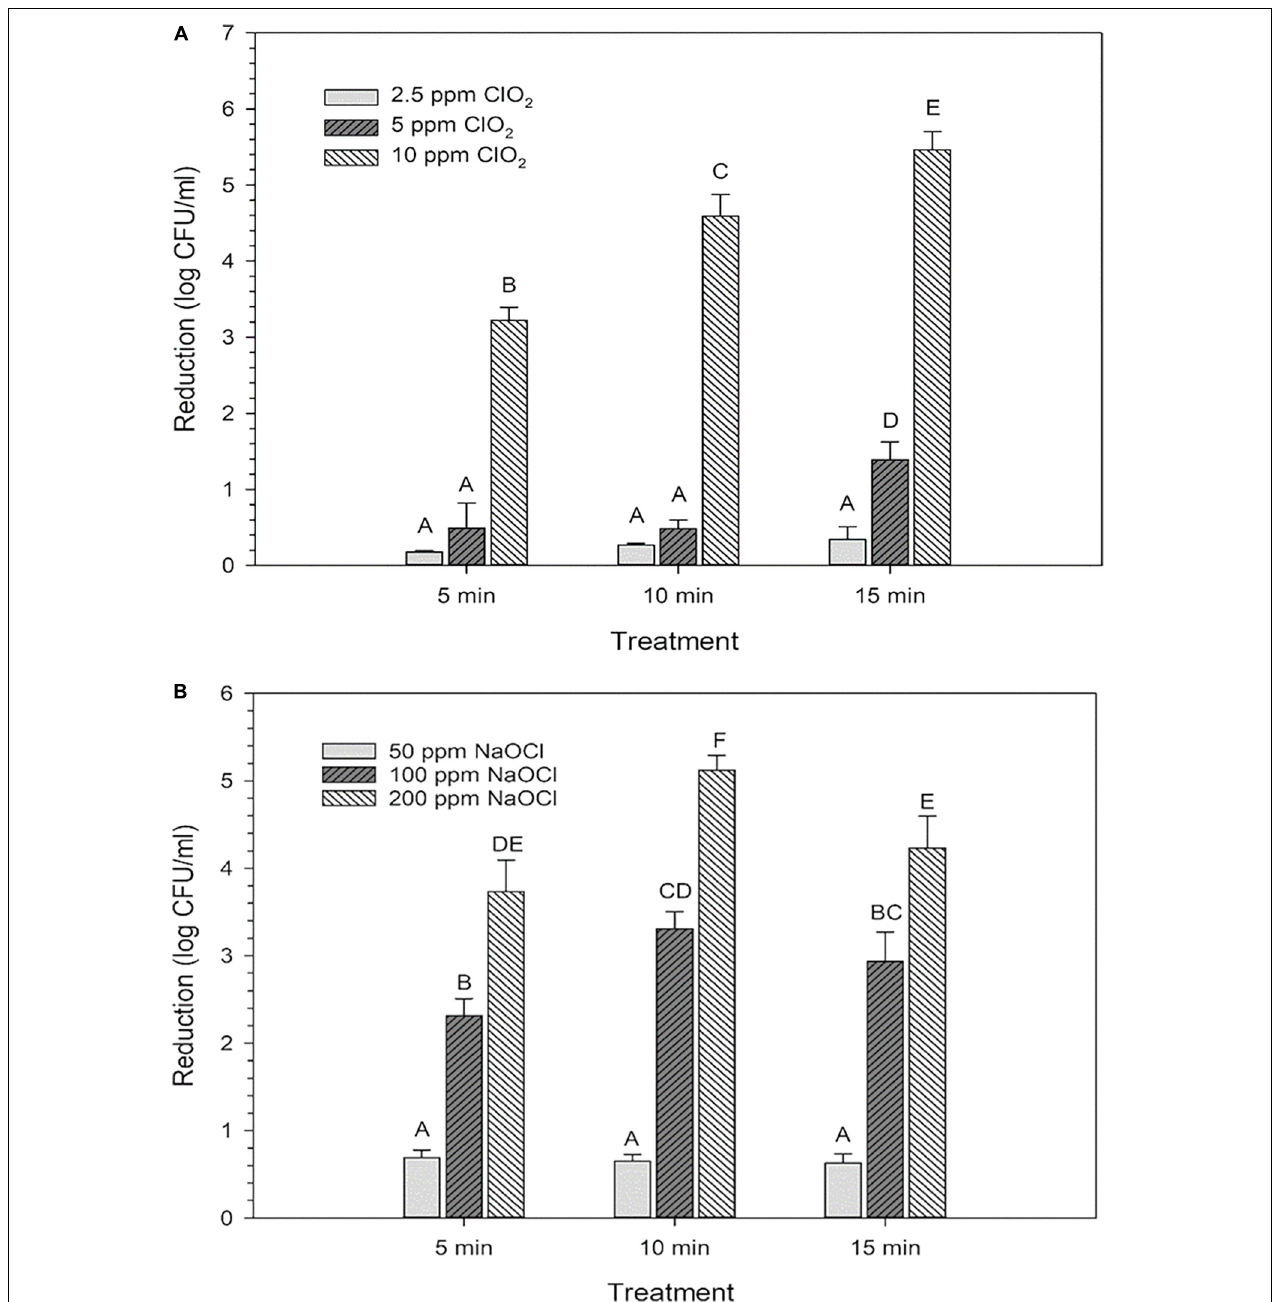
FIGURE 1 | Log reductions of Escherichia coli O157:H7 after 2.5, 5, or 10 ppm ClO 2 treatment for 5, 10, or 15 min compared (A) and treatment with 50, 100, or 200 ppm NaClO for 5, 10, or 15 min (B) . Data are presented as means ± standard deviations, and significant differences ( P ≤ 0.05) in bacteria reductions observed after each treatment are represented by different letters (e.g.,